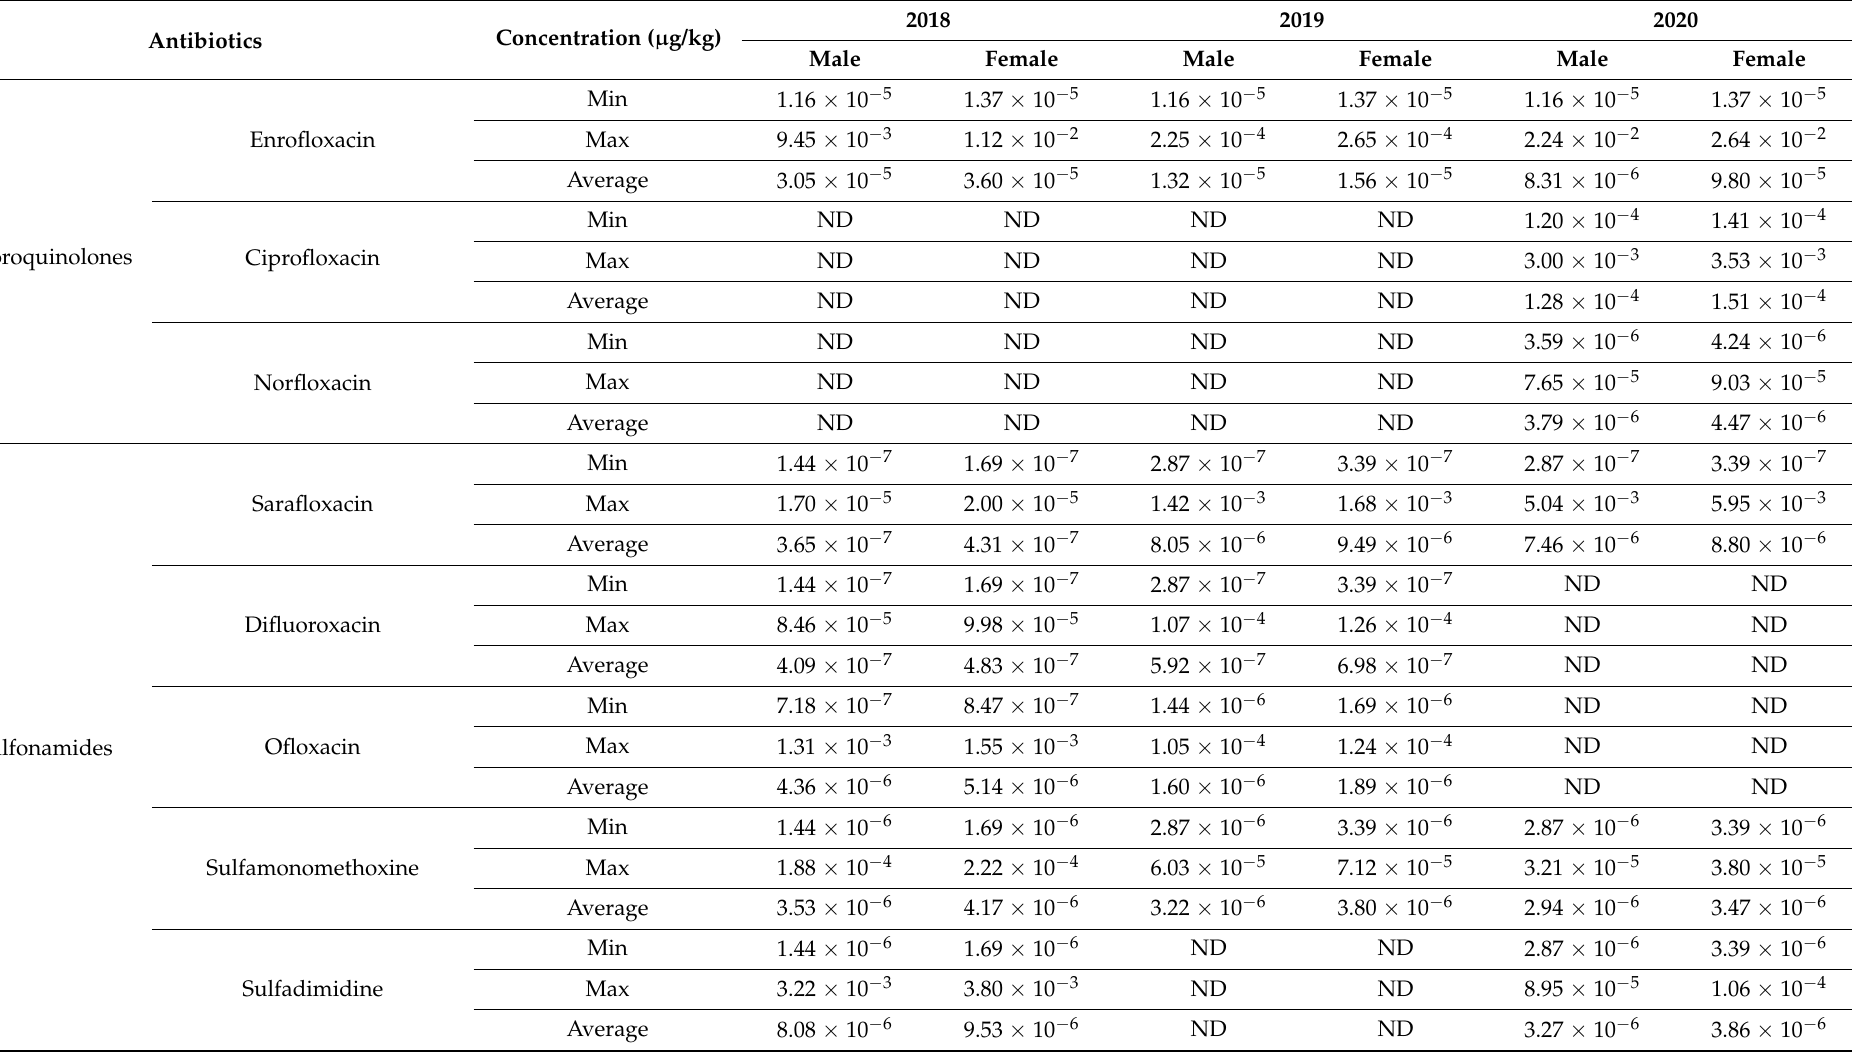
Table 7. International Food Safety indices (IFS) of poultry eggs in Shandong, 2018–2020 (average intake of eggs, 50 g/d/person).